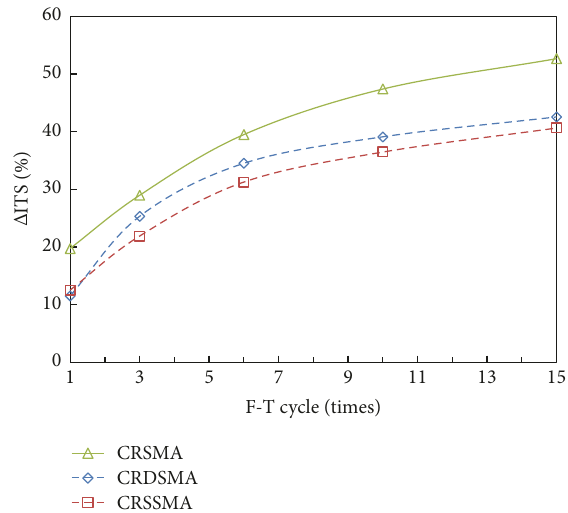
Figure 7: Relationship between Δ ITS and F-T